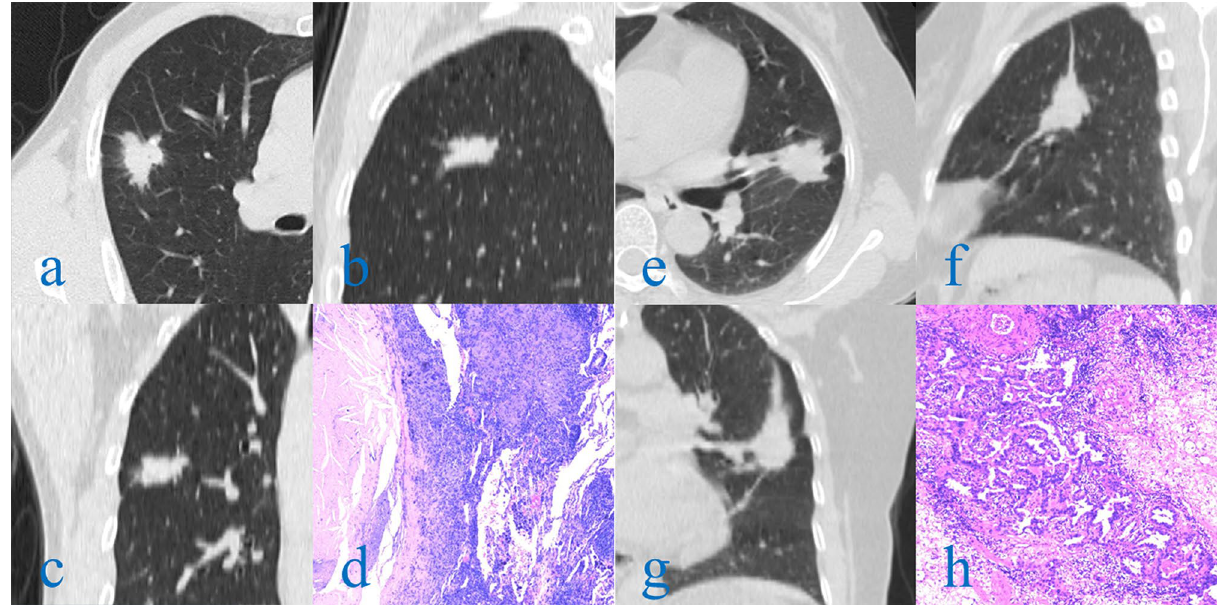
Figure 5. ( a – h ) Axial, Sagittal and Coronal CT images and pathological sections (HE, 400X, light microscope). A 65-year-old man underwent chest CT during "physical examination" and found right lung space-occupying lesions. The pathological diagnosis was tuberculous granulomatous nodule after operation. CT images showed superficial loculated nodules with rough edges, short and hard "burr", thin line like adhesion with pleura, and small blood vessels passing through the nodules ( a – c ). Pathological sections showed that the alveolar structure had been completely lost, and the multinucleated giant cells and epithelioid cells were disorderly accumulated ( d ). A 43-year-old female patient with coronary heart disease was diagnosed with left lung space-occupying lesion during coronary CTA. The pathological diagnosis was invasive adenocarcinoma after operation. CT images showed loculated, irregular nodules with smooth edge, long and soft "burr", pleural adhesion, vascular and bronchial convergence ( e – g ). Pathological sections showed that tumor cells with large nuclei and few cytoplasm accumulated along the alveolar wall ( h